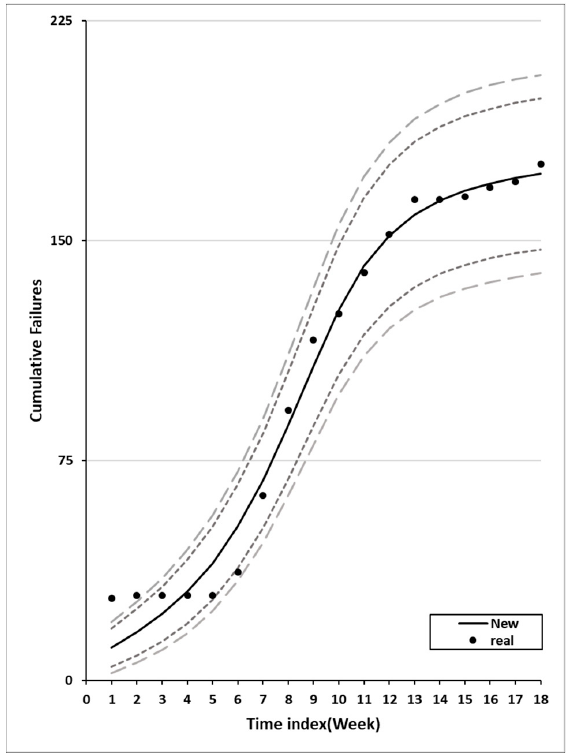
Figure 5. Actual data and estimated mean value function and confidence limits of the proposed model for Dataset #1.